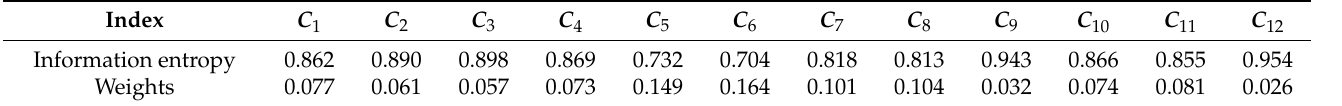
Table 4. The information entropy and the weight of each